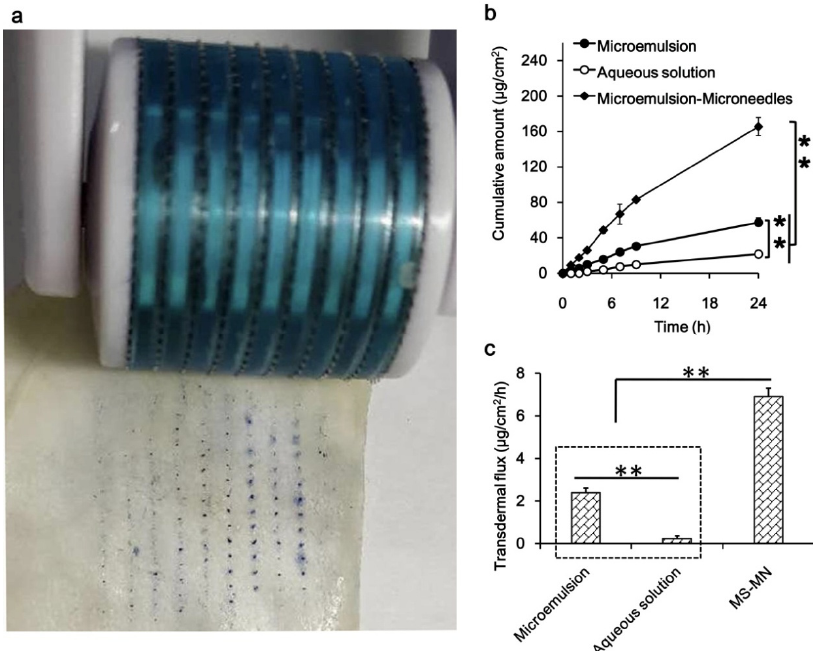
Figure 3. Microneedles and microneedle-treated rat skin ( a ), in vitro transdermal profiles ( b ), transdermal flux and skin deposition ( c ) of aconitine from microemulsion and the aqueous solution. ** p < 0.01, ( n = 3).